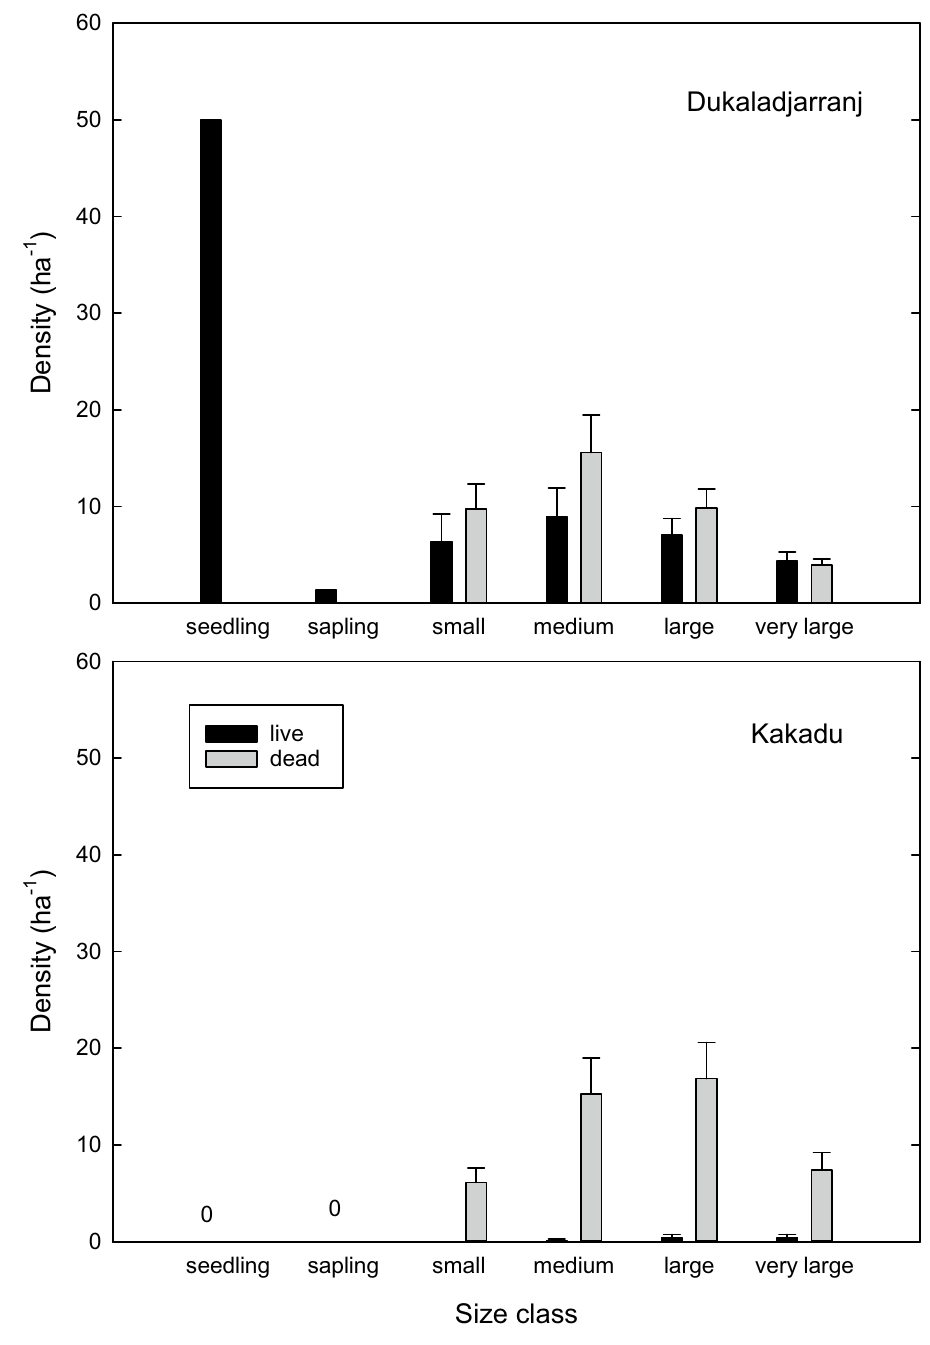
Figure 3. Mean (and standard error) densities of live and dead Callitris intratropica seedlings, saplings, and trees in Eucalyptus sand sheet savannas in transects in Kakadu National Park and the Dukaladjarranj Aboriginal estate in central Arnhem Land. Transects sampled a total of 8 ha in Kakadu National Park and 10 ha at Dukaladjarranj Aboriginal estate (Figures S1 and S2). None of the Kakadu transects contained any saplings or seedlings. Size classes are defined as: seedlings (< 0.1 m height), saplings (0.1–2.2 m height), small trees (≥ 2.2 m tall and < 10 cm diameter at 1 m height (D 1.0 )), medium trees (10–20 cm D 1.0 ), large trees (20–30